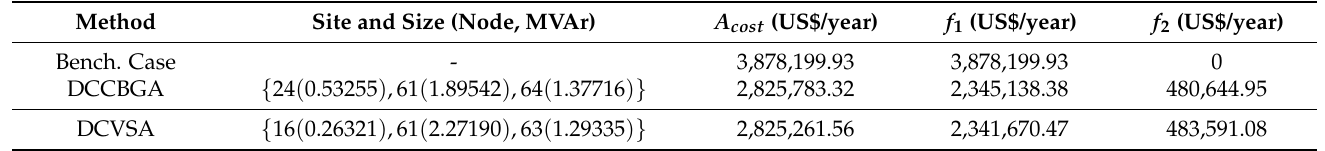
Table 4. Numerical results in the AC version of the IEEE 69-bus